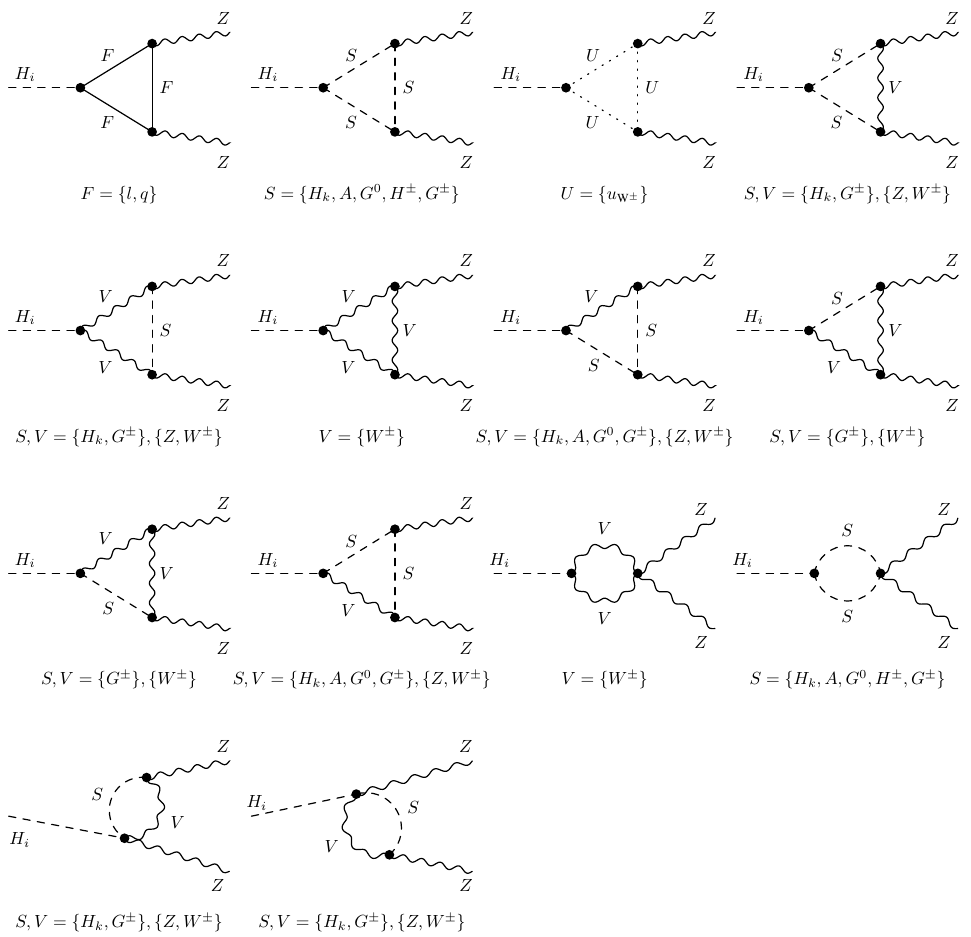
Figure 5 . Generic diagrams contributing to the vertex corrections in H i ! ZZ with fermions F , scalar bosons S , gauge bosons V and ghost particles U in the